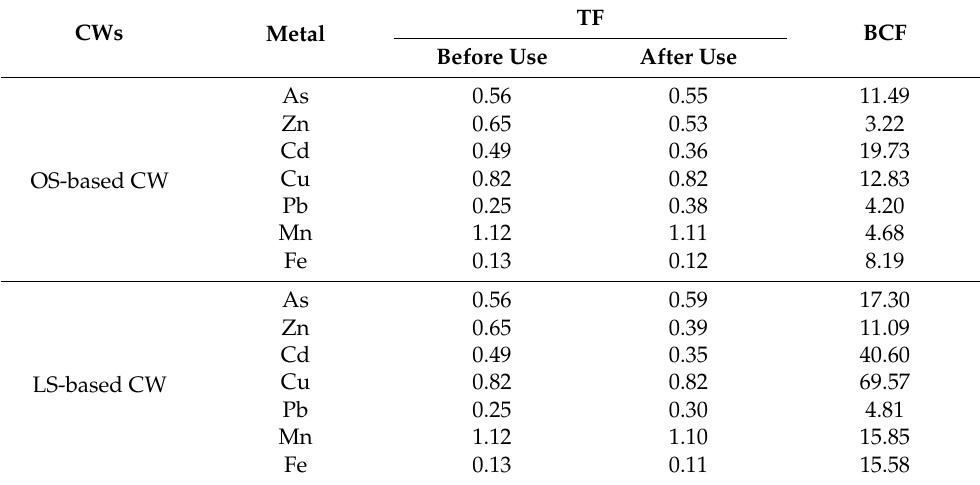
Table 4. BCF and TF values of cattails in the planted CWs after 7-month AMD